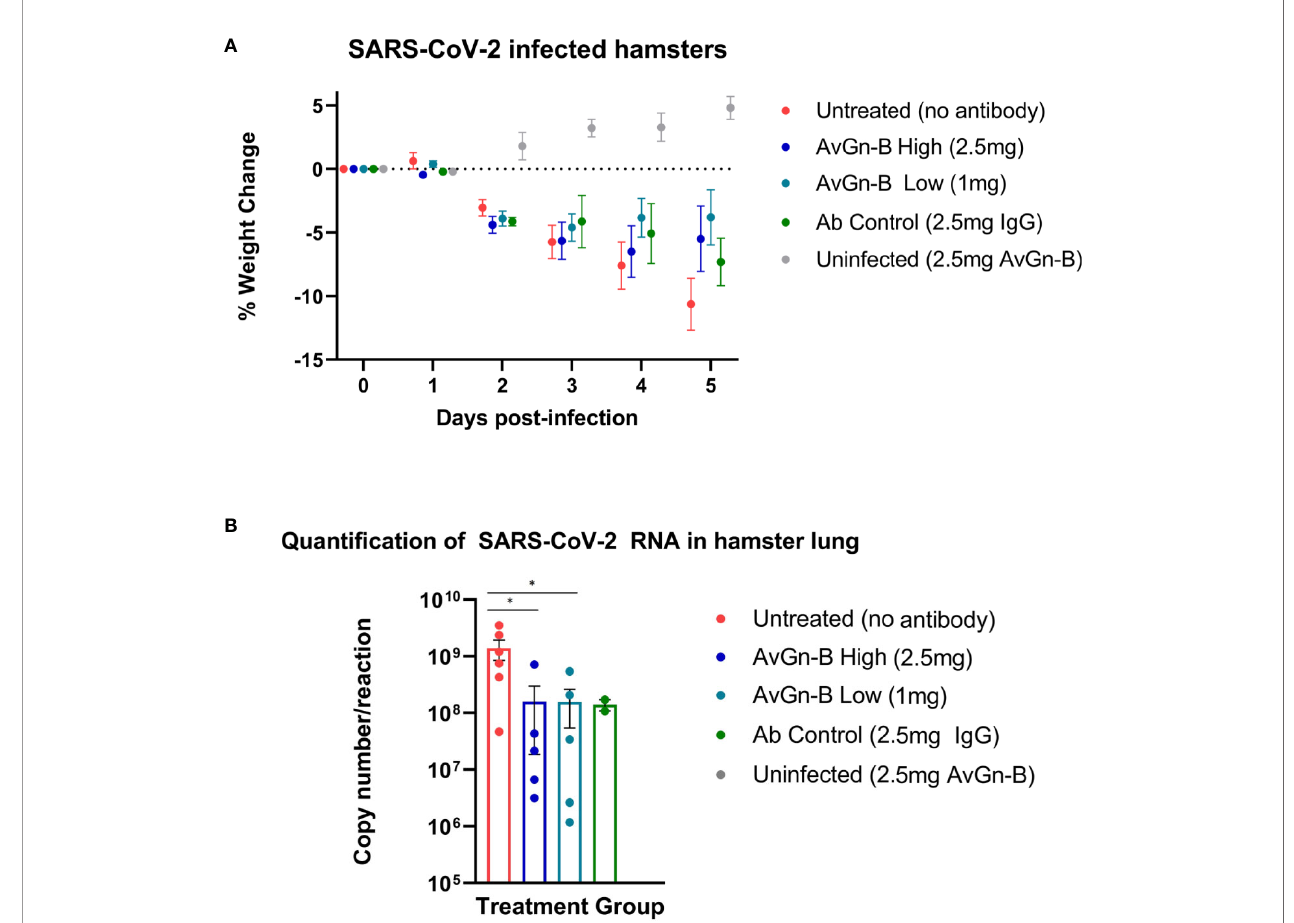
FIGURE 2 | Clinical presentation and viral load in the lungs of Syrian hamsters dosed with AvGn-B following SARS-CoV-2 infection. (A) Hamster body weights were recorded daily (0 – 5 dpi), and weight loss was de fi ned as percentage loss from 0dpi. Hamsters were separated by treatment group and weight loss was analyzed using multiple t-tests in Prism GraphPad for each day ( p > 0.05). (B) Viral load (gene copy number/reaction) in infected hamster lung was compared between treatment groups (analyzed by Mann-Whitney U Test in Prism GraphPad) (* p <